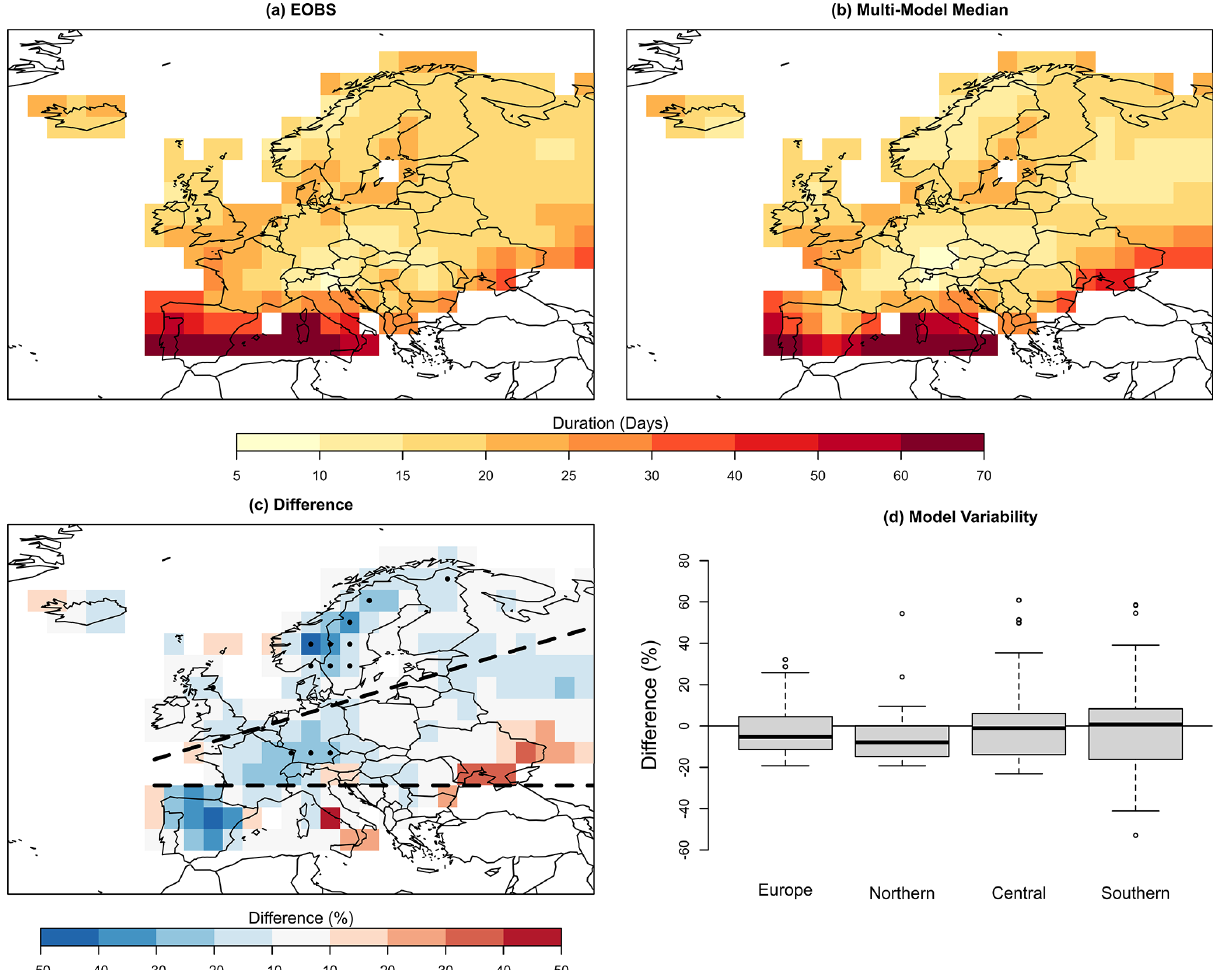
Figure 1. Duration return levels (RLs) of dry spells for a 5-year return period for (a) EOBS and (b) the median of the CMIP5 multi-model ensemble. (c) Percentage difference between CMIP5 multi-model median and EOBS (stippling indicates where 90% of CMIP5 models are below or above EOBS). (d) Model spread in the relative difference averaged across all grid cells in Europe, northern Europe, central Europe and southern Europe (dashed lines in (c) indicate the three European IPCC